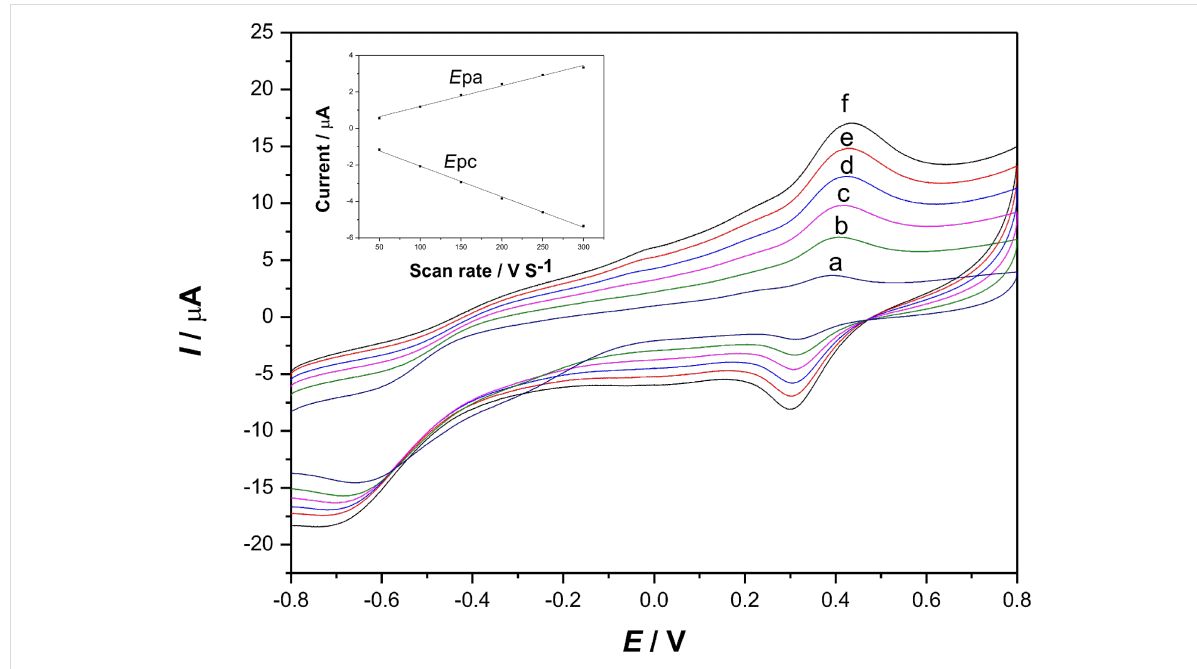
Figure 4: Cyclic voltammograms of the laccase – Nafion–ECNFs/GCE in acetate buffer (pH 4.0) with different scan rates (V·s − 1 ): (a) 0.05; (b) 0.1; (c) 0.15; (d) 0.2; (e) 0.25; (f) 0.3. Inset: Calibration plot of anodic and cathodic peak currents vs scan rates.